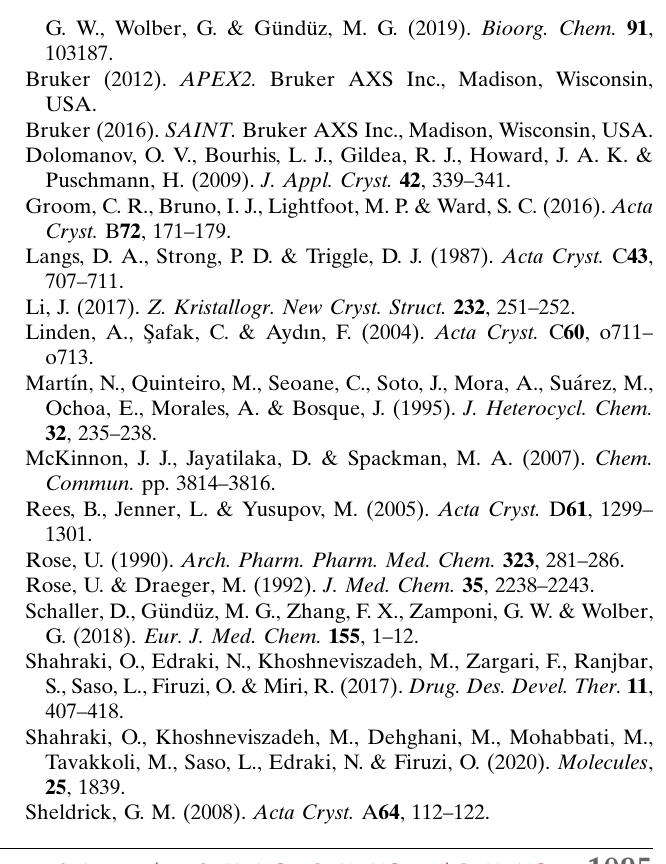
Crystal data Chemical